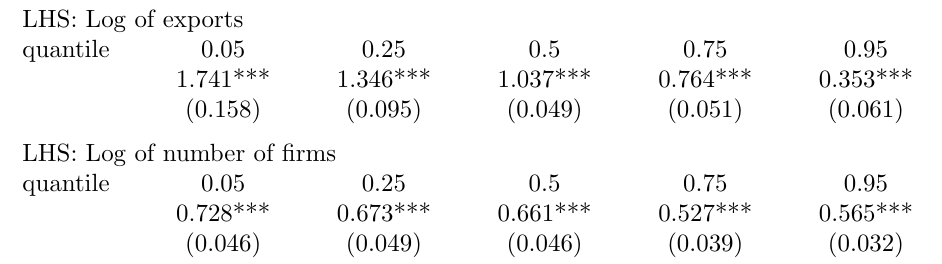
Figure 4: Regression quantiles for TA institutional quality Table 2: Results of the quantile estimation: the role of TA institutional quality in the intensive and extensive margins of